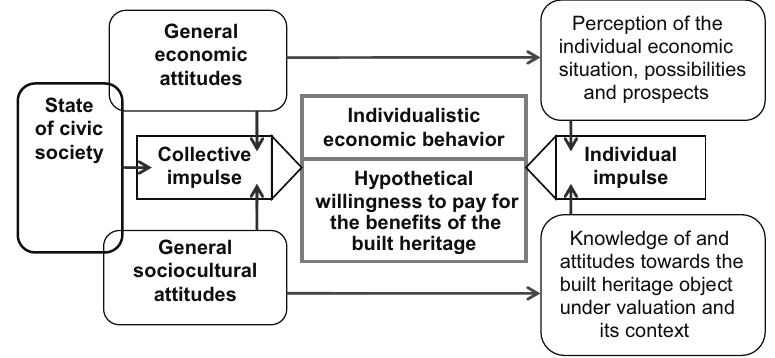
figure 1. Potential determinants of the